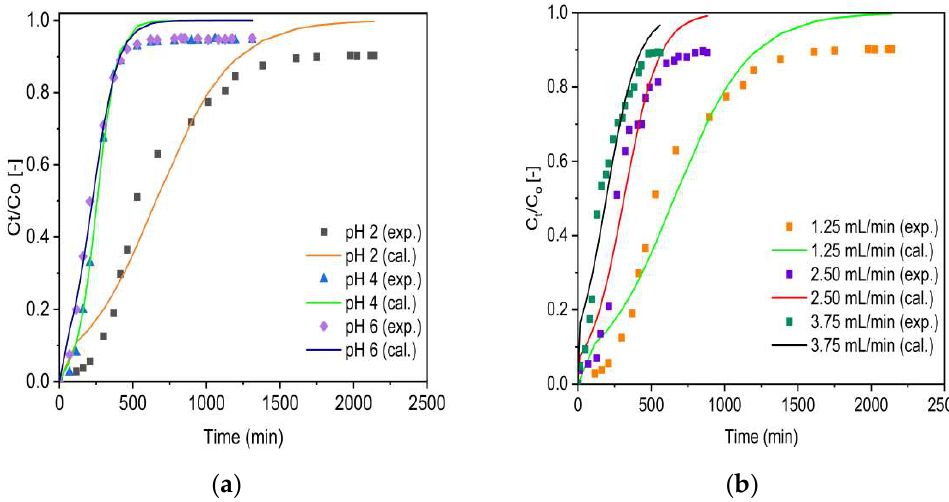
Figure 8. Experimental (exp.) and simulated (cal.; Thomas model) breakthrough curves of fluoride for VSco at different ( a ) pH (C O : 10 mg/L; Q O : 1.25 mL/min; bed depth 10 cm) and ( b ) initial flow rate, Q O (pH 2; C O : 10 mg/L; bed depth 10 cm).